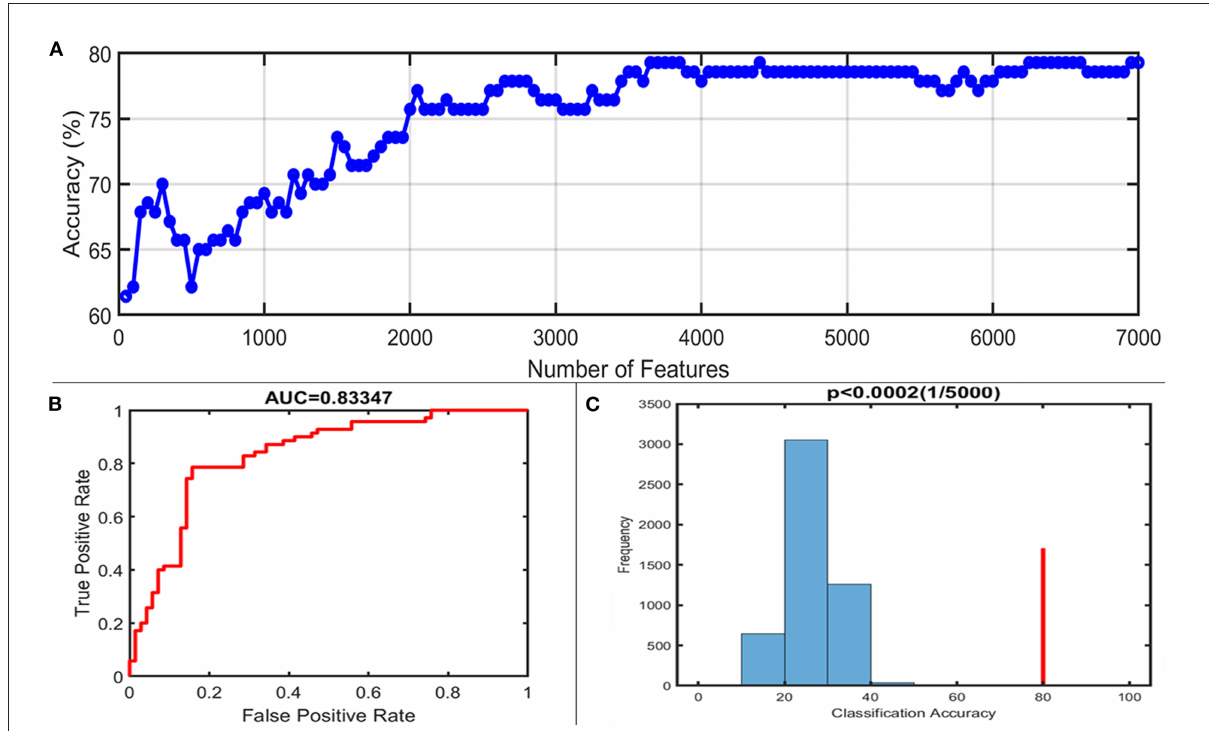
FIGURE2 Classification performance of the proposed approach. (A) The accuracy of classification with the increased number of features; when including 3,650 discriminative features, the highest accuracy of the classification model is 79.3%. (B) Area under the curve of the classification model (AUC = 0.83347) with the highest accuracy. (C) The result of the permutation test with the highest accuracy ( p <